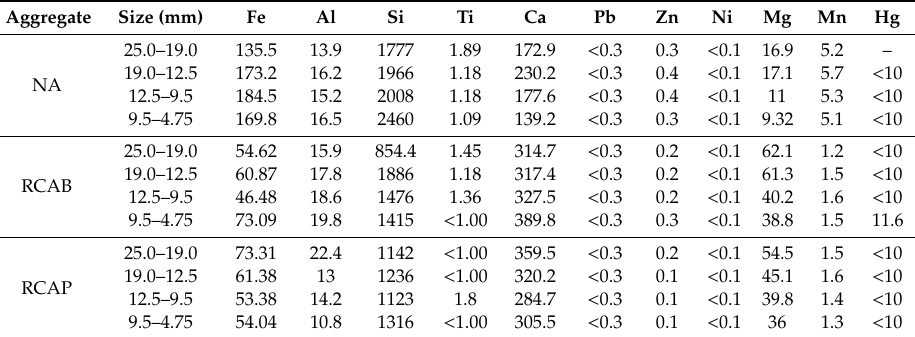
Table 8. Atomic absorption spectrometry pf water-soluble elemental contents (mg /